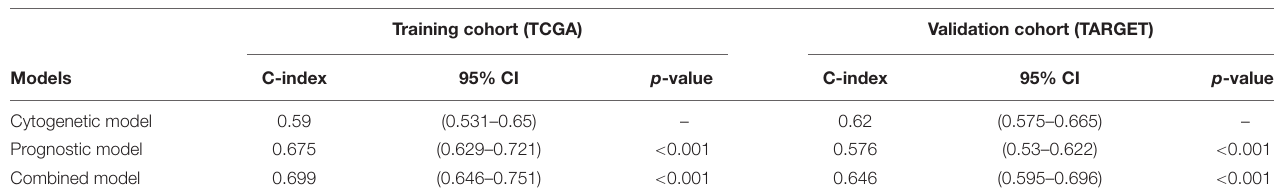
FIGURE 4 | Building and validation of the nomogram predicting overall survival for AML patients. Nomogram predicting median survival time for patients with AML (A) . The calibration curve for predicting 1–, 2– and 3–year overall survival (OS) for patients with AML (B) . The decision curve analysis (DCA) curve shows the 1–, 2–, and 3–year net benefit rate of the three models. Red, blue, and green, respectively, represent the cytogenetic model, prognostic model, and combined model (C–E) . TABLE 2 | Comparison of the cytogenetic model, prognostic model, and combined